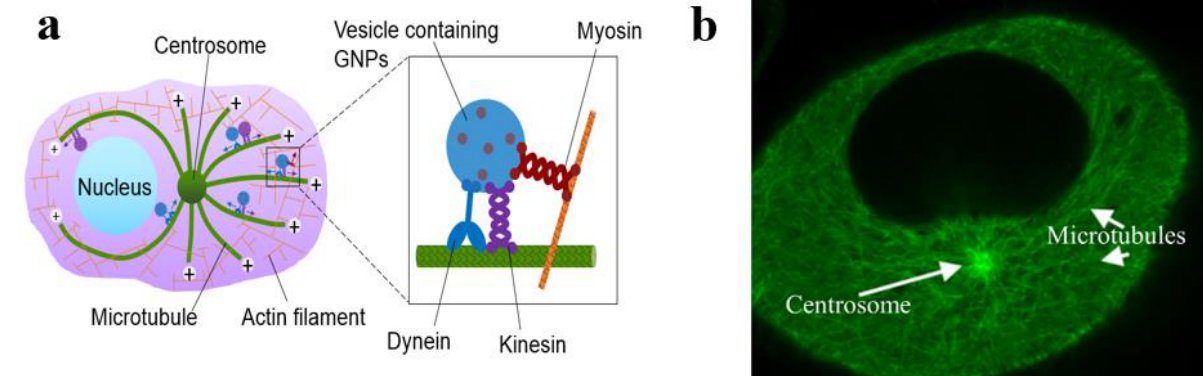
Figure 7. Microtubule network within a cell. ( a ) A diagram showing the transport of vesicles containing GNPs within the microtubule network. ( b ) A snapshot of a live cell showing a high number of microtubules throughout the cell. Reproduced from [86], MDPI, 2020.